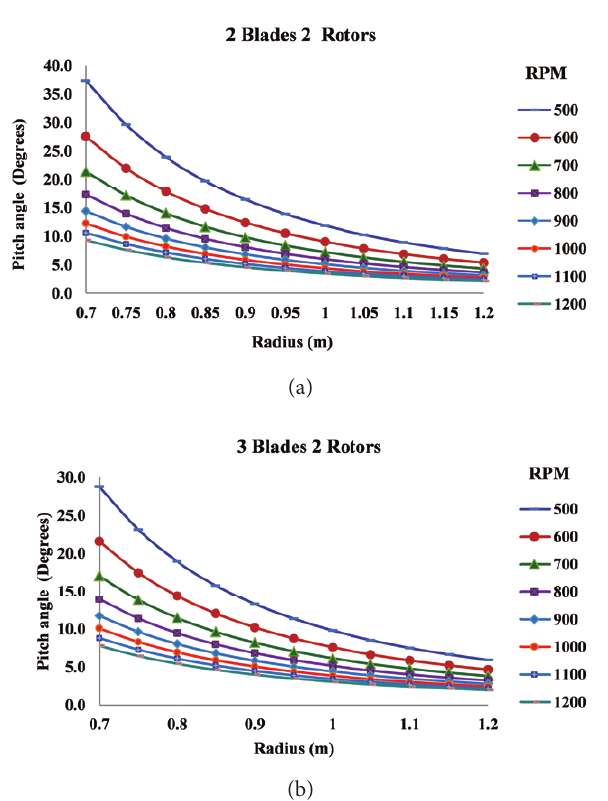
Figure 3. Pitch – Radius relation for 2-blade 2 rotor